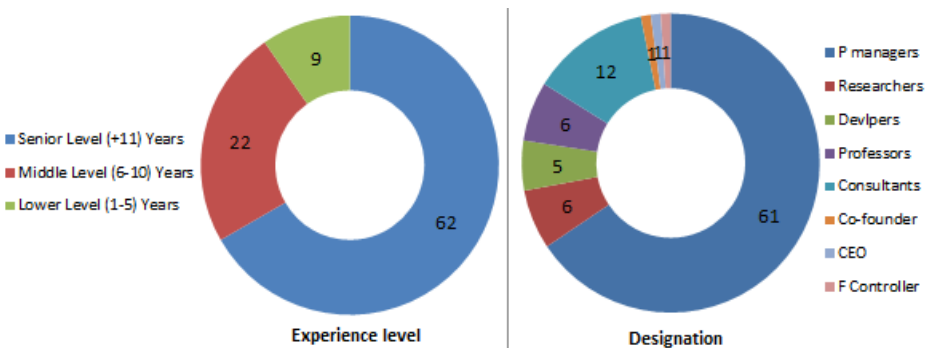
Figure 2. Designations of respondents and their experience